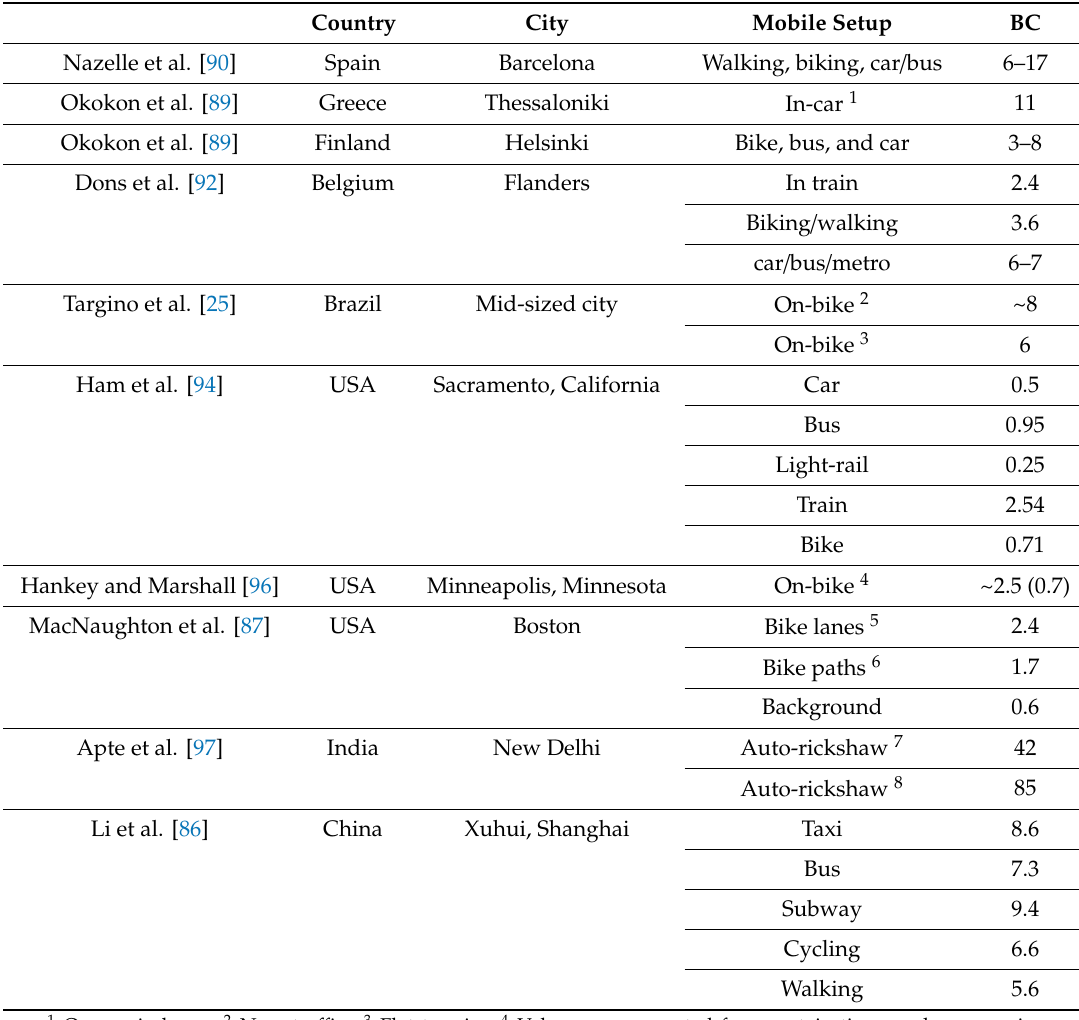
Table 2. Summary of selected literature about mobile measurements of black carbon ( µ g / m 3